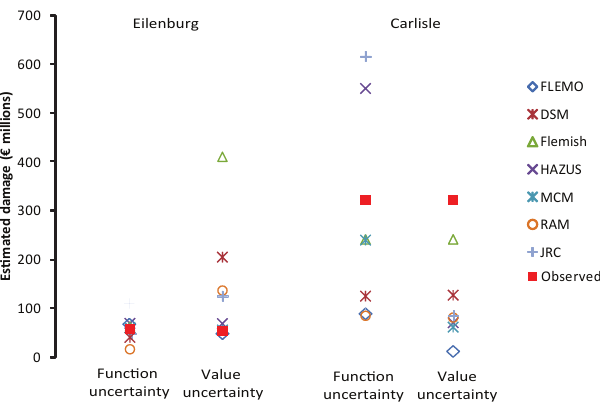
Fig. 8. Sensitivity of the model outcomes to changes in depth– damage functions and maximum damage values, residential areas (CLC 111 and 112). Function uncertainty is shown by keeping a constant maximum damage value (C100 for Eilenburg, C800 for Carlisle) while using the various depth–damage functions from all models. Value uncertainty is shown by keeping a constant depth– damage function (FLEMO for Eilenburg, MCM for Carlisle) while applying the various maximum damage